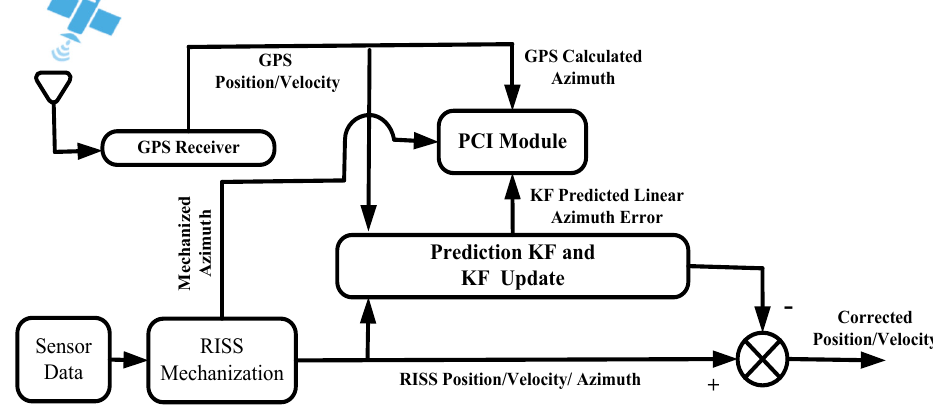
Figure 9. Loosely coupled KF-PCI technique during GNSS availability. When less than four satellites are visible, GNSS outage occurs, as a loosely coupled architecture is used. When there is a GNSS outage, the identified parallel cascade will be utilized to predict the azimuth errors (residual and non-linear) from the KF prediction for the linear azimuth error. After correction, the azimuth angle is passed to the new mechanization shown in Figure 10 to calculate the corrected position and velocity.